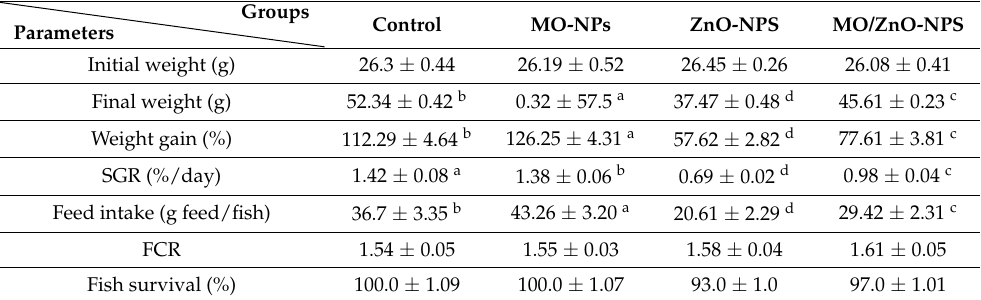
Table 1. Growth and feed utilization indices (mean ± SD) of Nile tilapia , O. niloticus exposed to ZnO-NPs with MO leaves nanoparticles administration for 2 months.